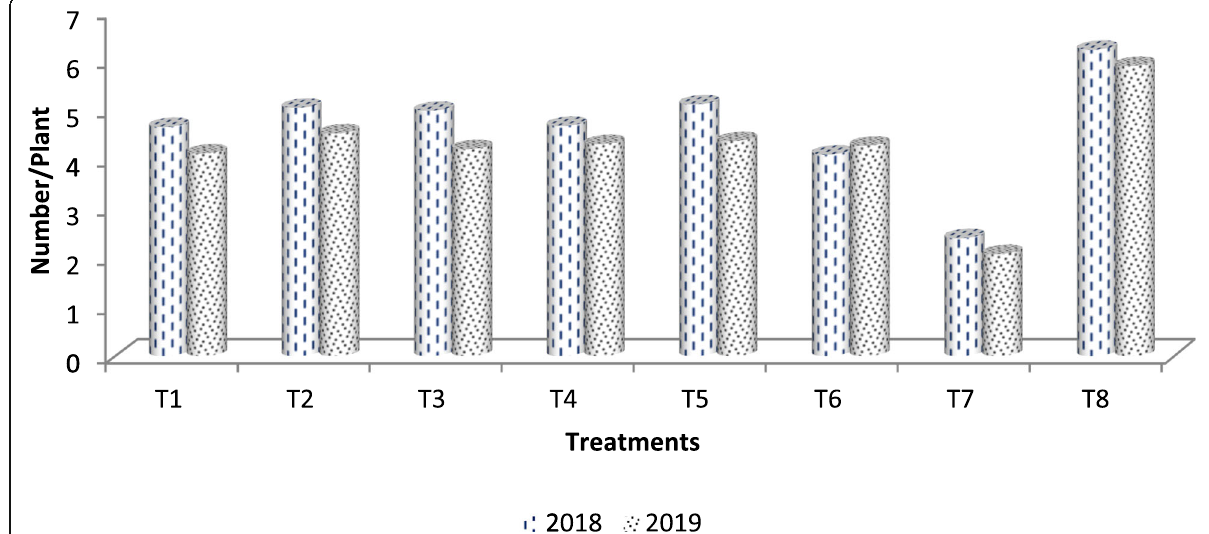
Fig. 2 Effect of different entomopathogenic fungi and neem oil alone and their combination (1:1) against Micraspis